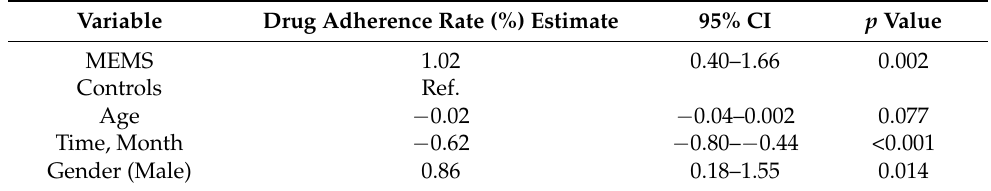
Table 3. Generalized linear mixed model estimating the time course of accumulated monthly drug adherence rate for TB medication over six